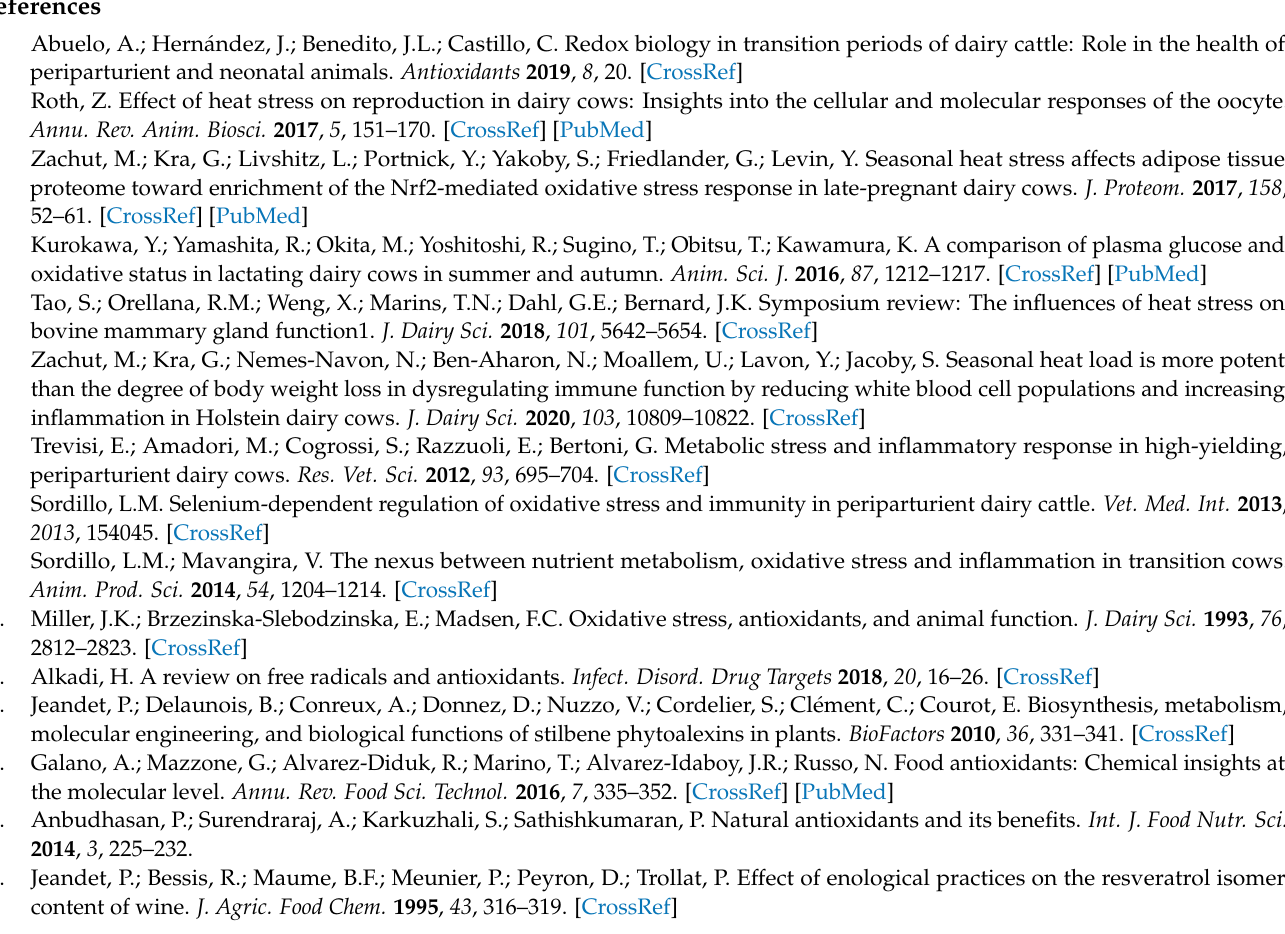
tissue, Figure S2: Cell viability of RSV treatment at different concentrations by DAPI staining, Table S1: RSV effect on the MDA and ORAC levels in DFAT cells, Table S2: RSV effect on the relative quantification (RQ) of different genes’ expression under short and long heat